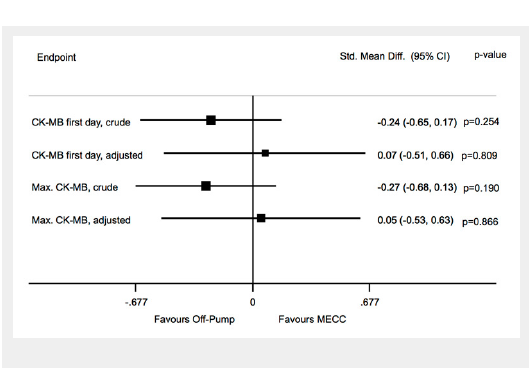
Figure 4 Forest plot regarding the values of CK-MB on the first postoperative day as well as peak